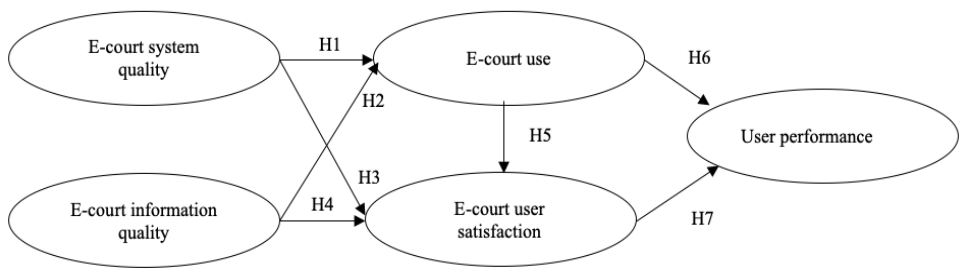
Figure 1. Research framework.